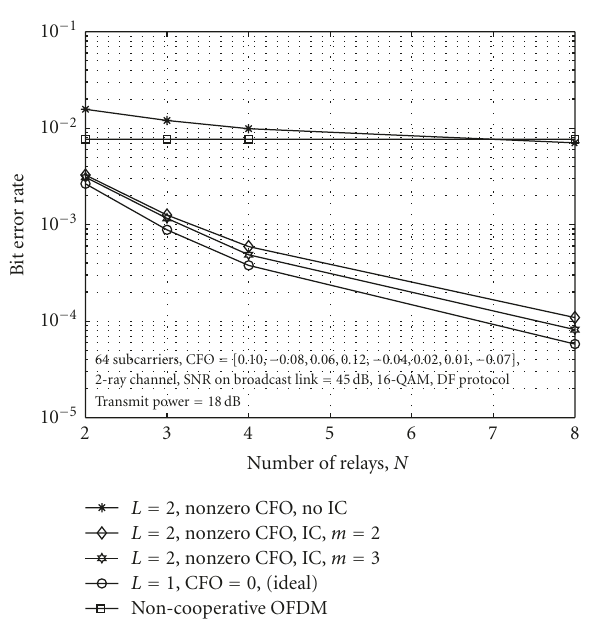
Figure 9: BER performance as a function of number of relays for CO-SFBC-OFDM on frequency-selective fading ( L = 2). M = 64, at a transmit power of 18 dB per bit. CFO = [0.1, − 0.08, 0.06, 0.12, − 0.04, 0.02, 0.01, − 0.07], 16-QAM, SNR in broadcast links = 45dB. G 2 , G 3 , G 4 and G 8 codes with rates 1, 3/4, 3/4 and 1/2 are used. DF protocol is employed at the